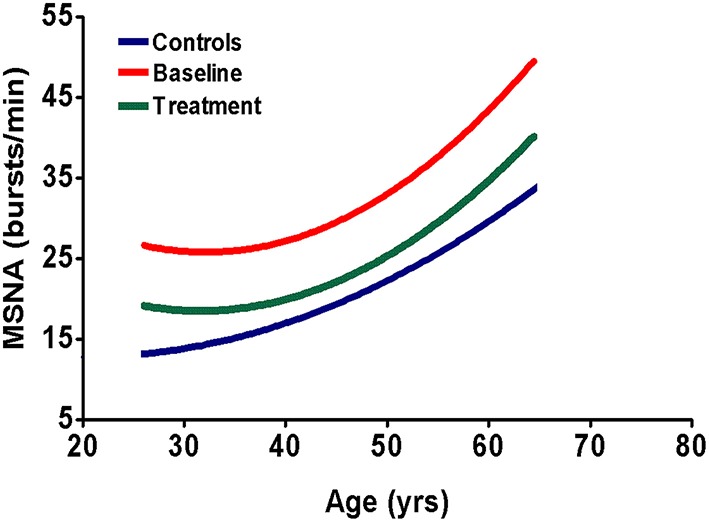
Schematic representation of sympathetic nerve activity in CKD patients and normal subjects. The blue line represents muscle sympathetic nerve activity (MSNA) in healthy subjects, the red line represents MSNA in untreated CKD patients and the green line represents MSNA in CKD patients, when treated chronically with a RAAS-inhibitor (Ligtenberg et al., 1999; Klein et al., 2003; Neumann et al., 2004, 2007; Siddiqi et al., 2011). Sympathetic activity increases with age, irrespective of treatment. The figure shows that chronic treatment with RAAS-inhibitors does not result in full normalization of MSNA. This indicates the need for additional sympatholytic therapy.